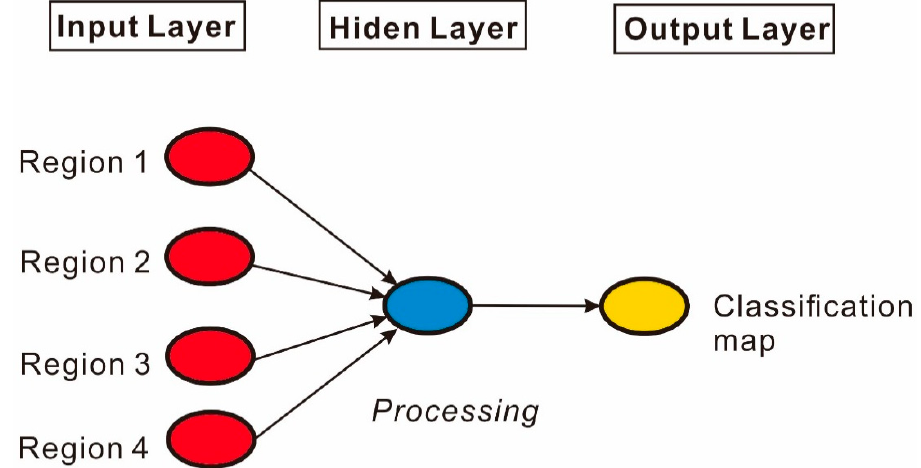
Figure 4. Artificial neural network model used for data analysis. Input layer data Regions 1–4, which are select in ENVI. The output layer is the classification map.